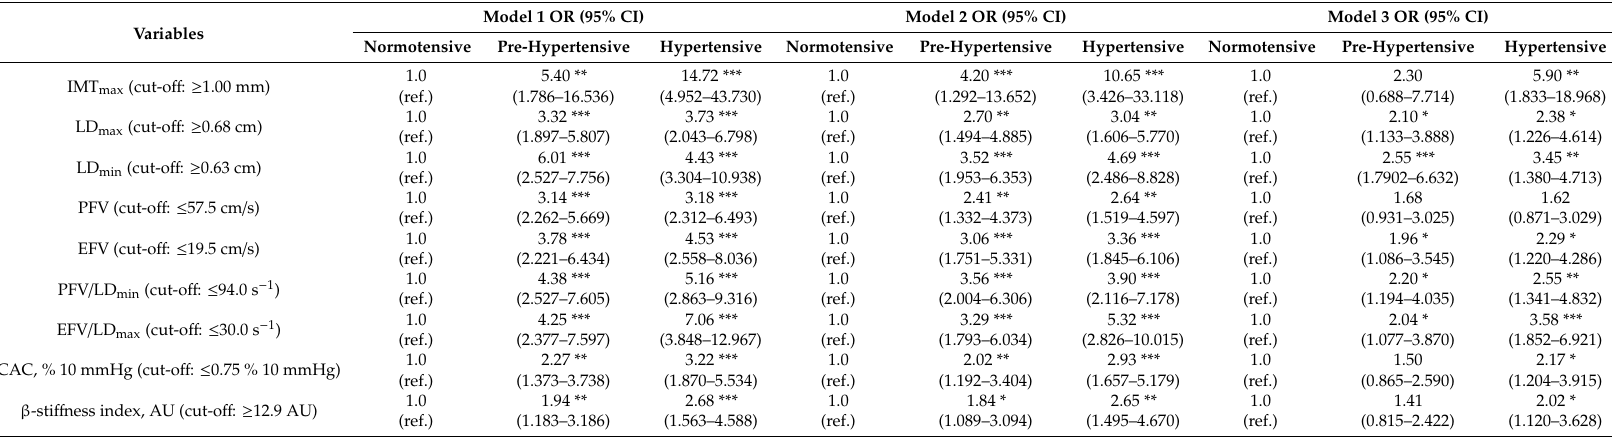
Table 5. Odds ratios with 95% CIs for cut-o ff points of carotid artery characteristics among groups according to blood pressure category after multivariate